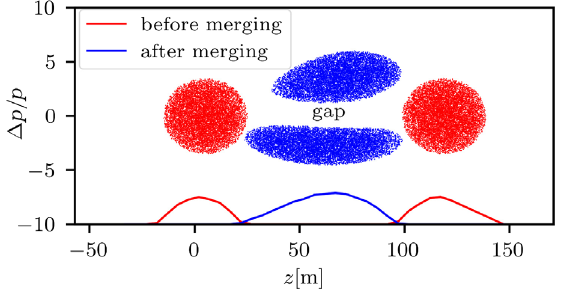
FIG. 14. Proposed proton bunch merging process in CSNS/ RCS. The solid lines denote the line density profile.